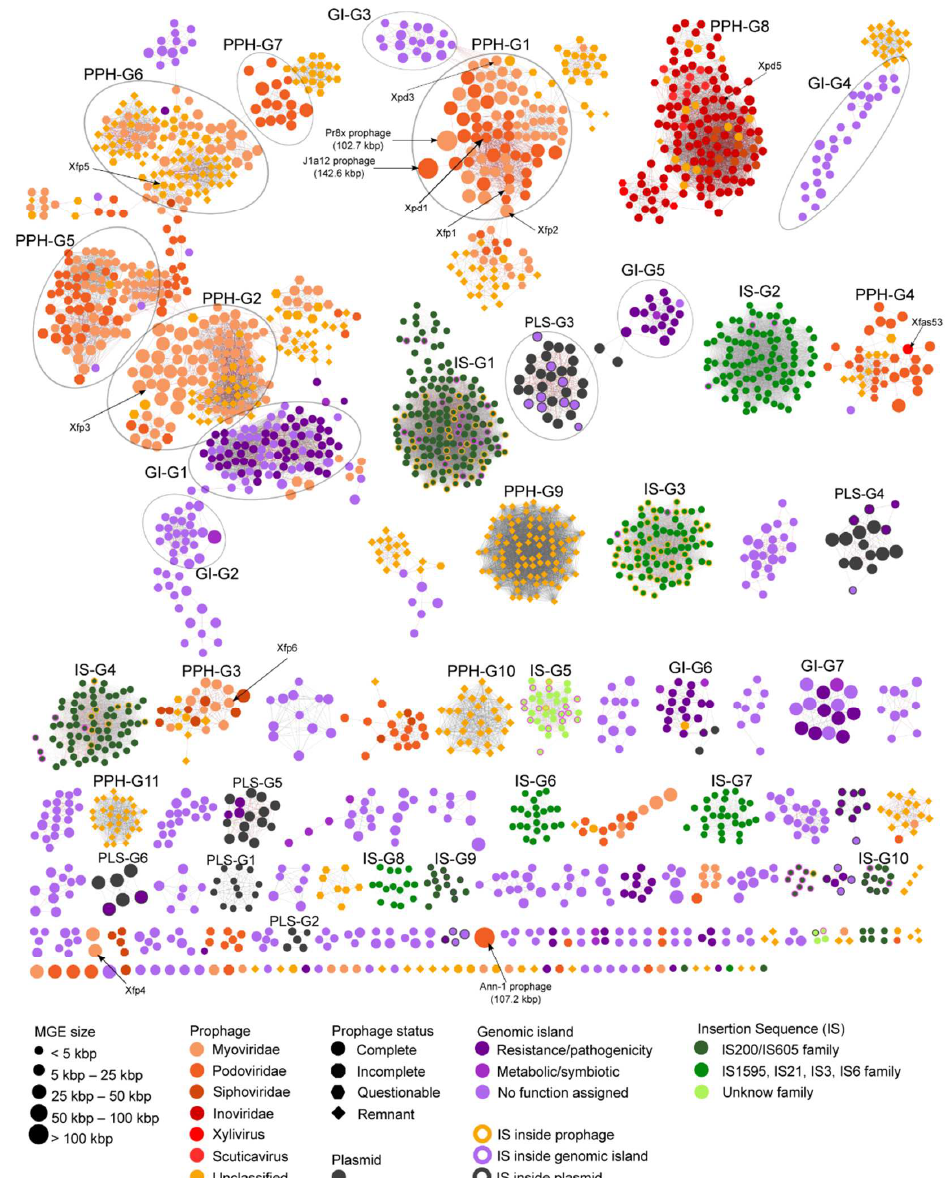
Figure 5. Sequence Similarity Network of the X. fastidiosa mobilome. The distinct MGEs (prophages (PPH), genomic islands (GI), insertion sequences (IS) and plasmids (PLS)) predicted in the 94 genome assemblies analyzed are indicated by the symbols (nodes) and the color code indicated on the bottom of the figure. Edges (lines connecting the symbols) represent the similarity of nucleotide sequence with an identity and coverage alignment higher than 50% and 80%, respectively. Symbol sizes shown in the bottom left represent MGE length in kbp. Prophage families and status are represented by different color circles and different shapes, respectively. Symbols of MGEs carrying ISs are outlined in orange (prophage), purple (genomic island) and dark gray (plasmid). PPH-G, GI-G, IS-G and PLS-G refer to the distinct groups highlighted in this work corresponding to prophages, genomic islands, insertion sequences, and plasmids, respectively. Previously reported prophage sequences are indicated (ex: Xfp6). Details of the MGEs pictured in the network are listed in Table